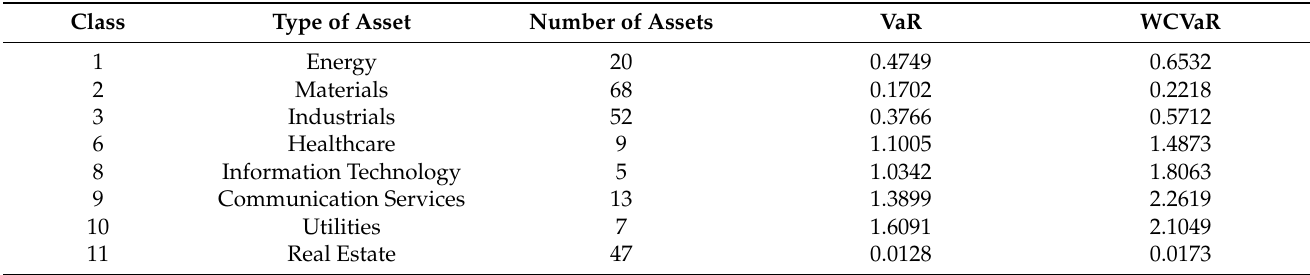
Table 2. Generating VaR and WCVaR using WCVaR technique for the GCC